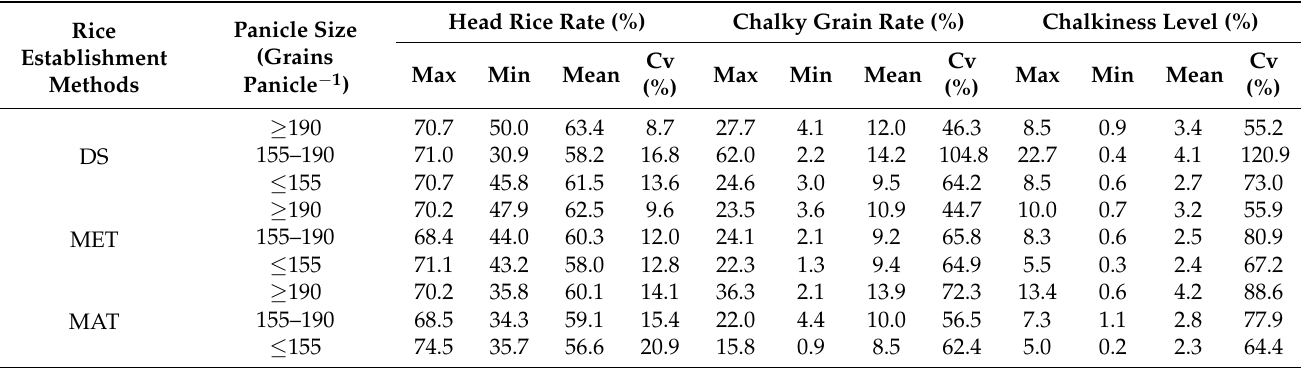
Table 5. Variation of grain quality for hybrid indica rice (HIR) with different panicle sizes in different establishment methods. DS, MET, and MAT represent directed-seeded rice, mechanical transplanted method, and manual transplanted